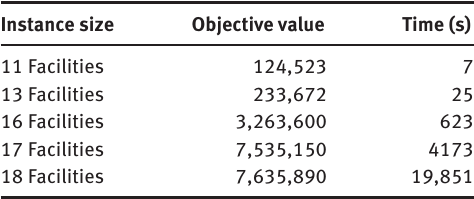
Table 3: Obtained Results in Ref. [3].